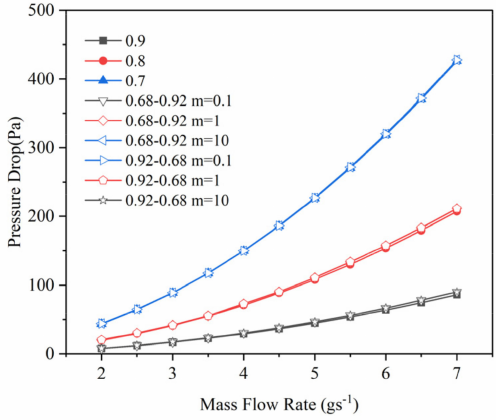
Figure 16. Pressure drop with AFHS with gradient porosity designed in the X -axis